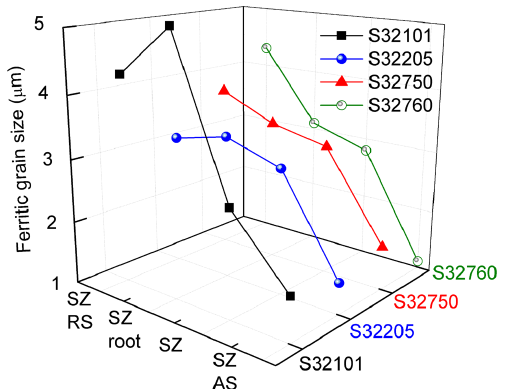
Fig. 13. Ferritic grain size in the stir zone for all samples.